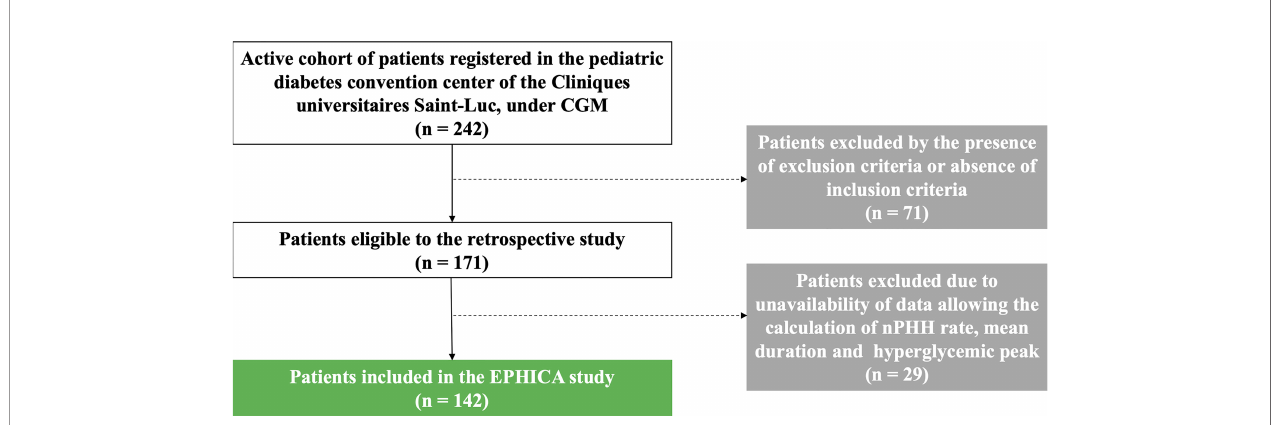
FIGURE 2 | Flow chart of the EPHICA study. Among de 242 patients registered in the pediatric diabetes convention center of the Cliniques universitaires Saint-Luc, 71 patients were excluded by the presence of exclusion criteria or absence of inclusion criteria. Among the 171 patients eligible to the retrospective study, 29 patients were excluded due to unavailability of data allowing the calculation of the PHH rate, the mean duration and the hyperglycemic peak of PHH. Finally, 142 patients were included in the EPHICA study.